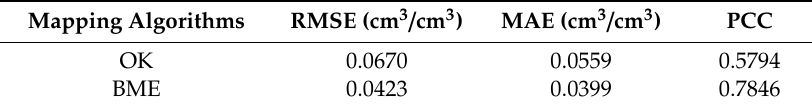
Table 5. The root mean squared error (RMSE), mean absolute error (MAE), and Pearson correlation coefficient (PCC) between the measured and estimated soil moisture values based on the independent validation dataset.